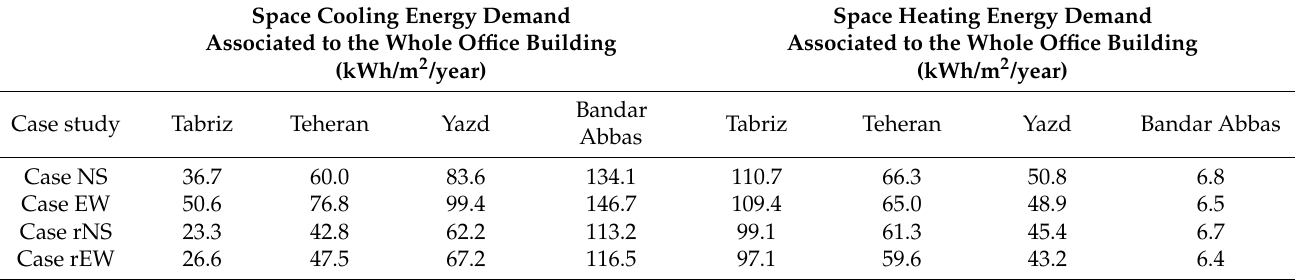
Table 6. Yearly cooling and thermal energy demand per square meter associated with the whole building for each case